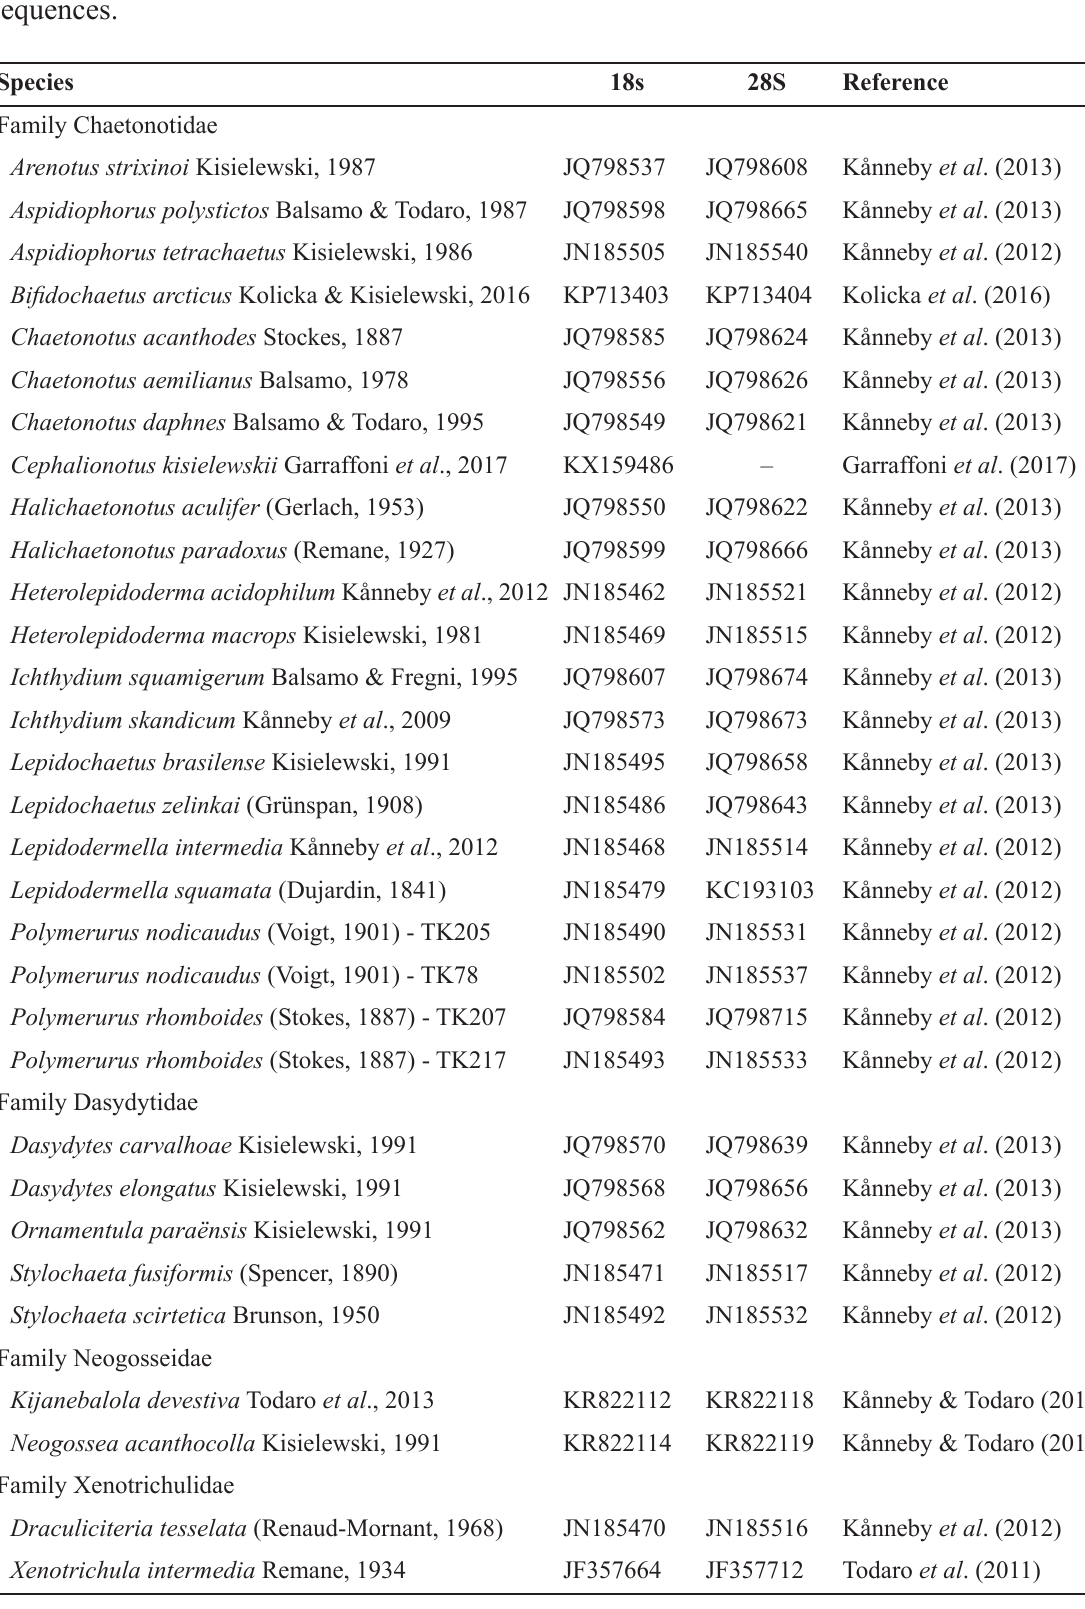
Table 1. Taxa included in this study, with GenBank accession numbers of 18S and 28S rDNA